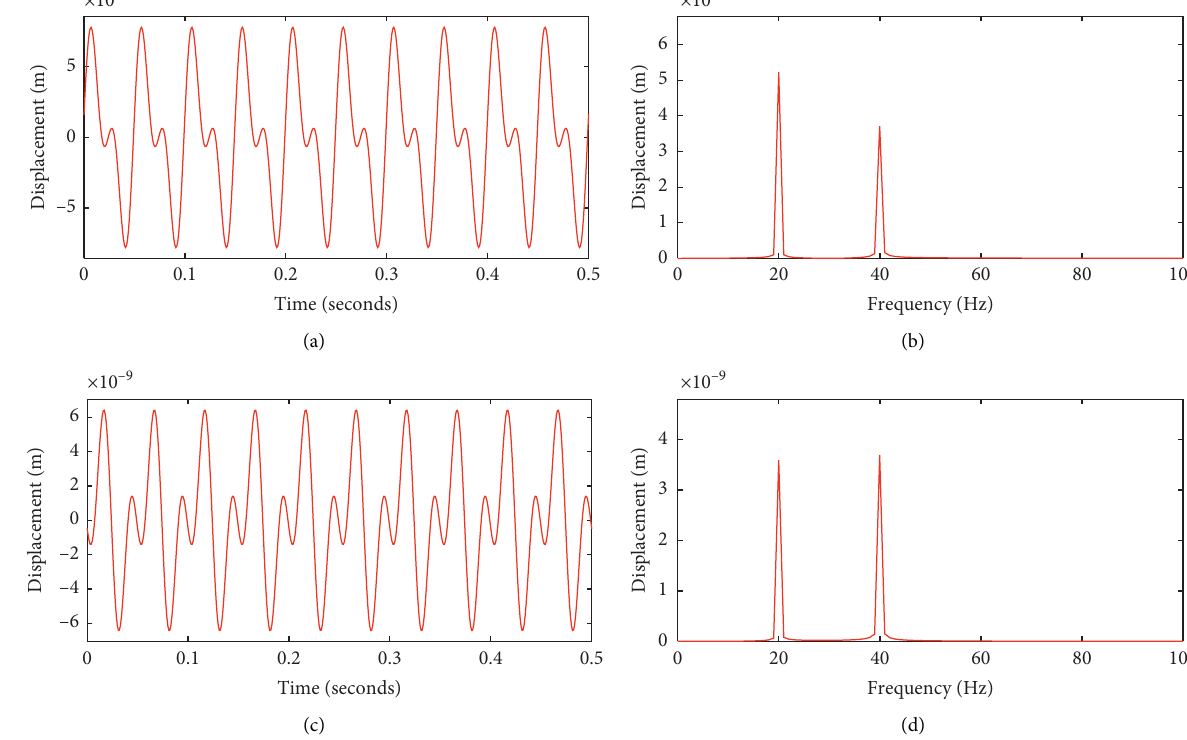
and x , under the combined effects of imbalance and angular 1 2